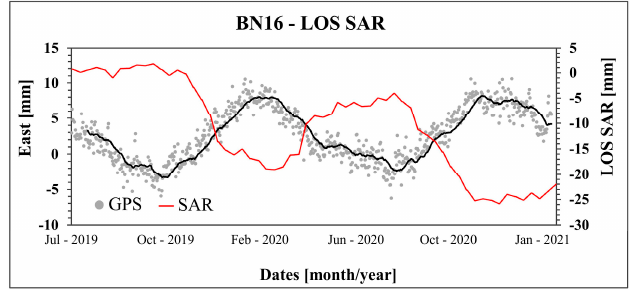
Figure 5. GPS and SAR time series, for BNL16 station and LOS SAR direction.